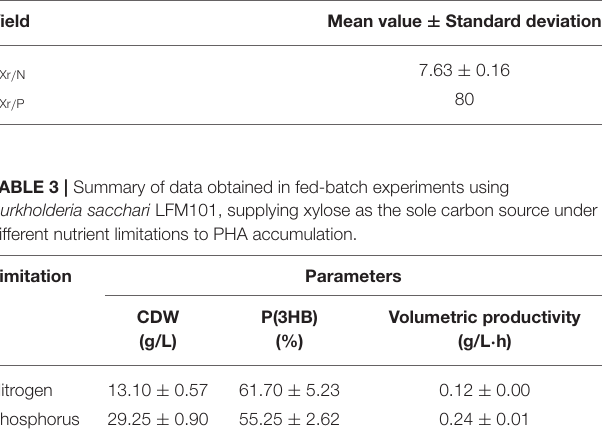
TABLE 5 | Features of B. sacchari inorganic phosphate transport and polyphosphate production genes and protein identity to E. coli